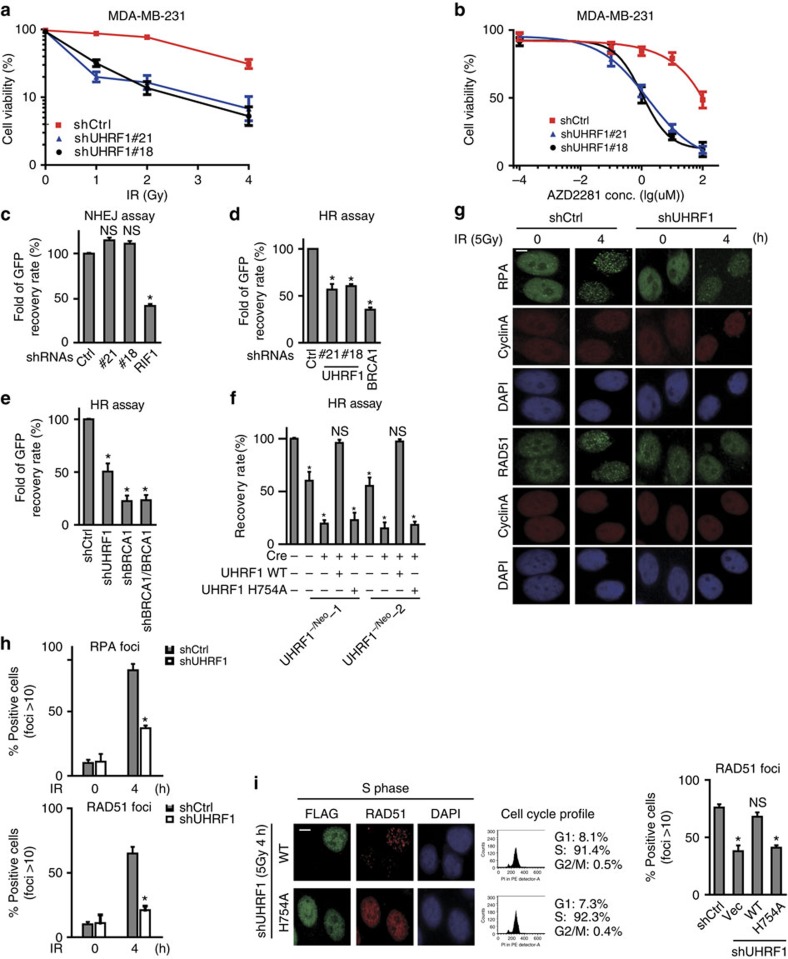
UHRF1 is involved in DNA repair through its E3 ligase activity.(a) MDA-MB-231 cells stably expressing the indicated shRNAs were irradiated. Radiation sensitivity of cells was determined by colony formation assays. Data were presented as mean±s.d. of three biological triplicates. (b) MDA-MB-231 cells stably expressing indicated shRNAs were treated with increasing doses of PARP inhibitor (AZD2281). MTS assay was performed to determine the surviving fraction. Data presented as mean±s.d. of three biological triplicates. (c–e). HEK293 cells integrated with NHEJ or HR reporter were transfected with the indicated shRNAs and subjected to the NHEJ assay (c) or HR assay (d,e) as described in Methods. Data presented as mean±s.d. of three biological triplicates.. Positive cell percentage compared with control group. *P<0.05. NS: no siginficant difference. (f). UHRF1flox/hypo cells transfected with HR reporter were treated as indicated. HR assay were performed as described in Methods. Data presented as mean±s.d. of three biological triplicates. Positive cell percentage compared with control group. *P<0.05. NS: no siginficant difference. (g,h). UHRF1 regulates RPA and RAD51 IRIF. RPA and Rad51 foci formation were examined in synchronized HeLa cells stably expressing control or UHRF1 shRNA following irradiation (5 Gy). Cyclin A was stained as a cell cycle marker. (g) Representative micrographs. (h) Quantification data (foci>10 per cell). For each sample, randomly selected S phase cells (n=400) were counted. Data presented as mean±s.d. of three biological triplicates. Positive cell percentage compared with control group. *P<0.05. Scale bar, 10 μm. (i). HeLa cells stably expressing UHRF1 shRNA (targeting 3′-UTR) were reconstituted with the indicated constructs and synchronized in S phase. RAD51 foci were examined following irradiation (5 Gy 4 h). left: Representative micrographs. Right: Quantification of the positive cells (foci>10 per cell). For each sample, 400 randomly selected cells were counted. Data presented as mean±s.d. of three biological triplicates. Positive cell percentage compared with control group. *P<0.05. NS: no siginficant difference, Scale bar, 10 μm.